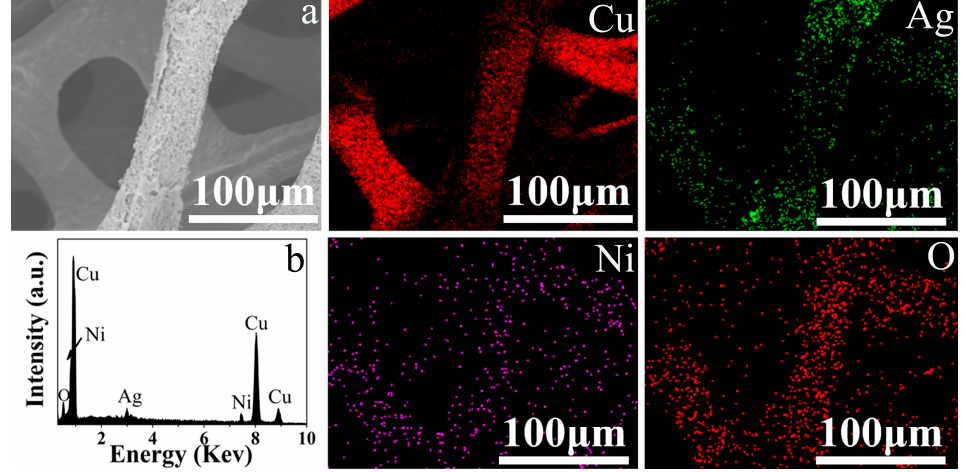
Figure 2. Ag/Ni(OH) 2 composite: ( a ) FE-SEM images and the corresponding EDS element mapping images of Cu, Ag, O and Ni elements; ( b ) EDS spectrum.